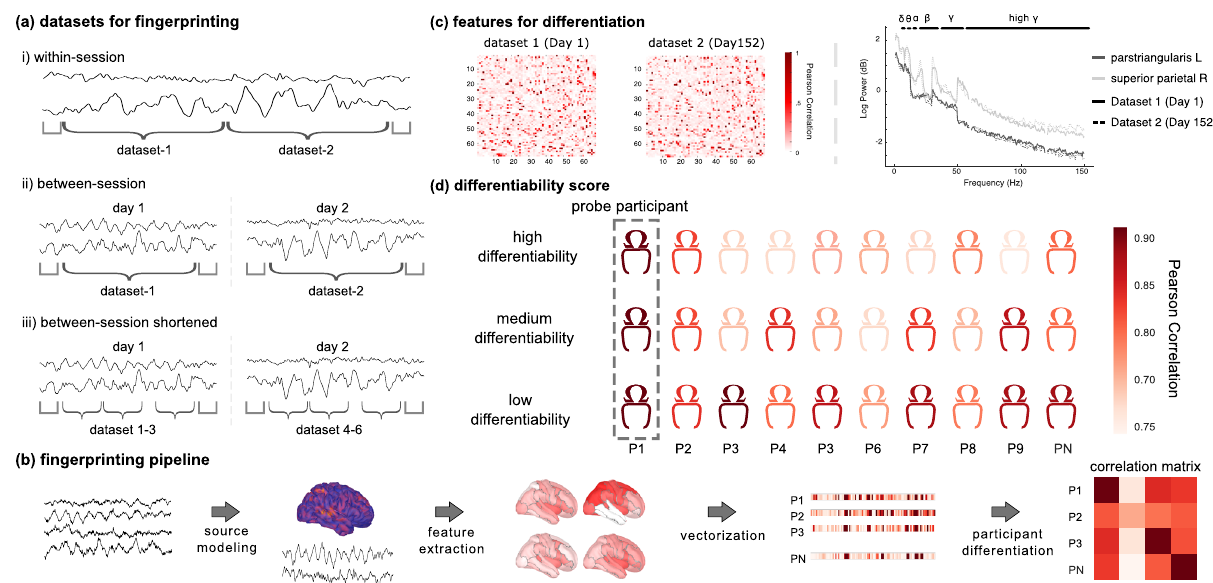
Fig. 1 Neural fi ngerprinting analysis pipeline and de fi nition of differentiability. a Schematic of exemplar MEG data divided into datasets used in each of the speci fi ed differentiation challenges. (i) Within-session challenge: the session data was split in half to generate segments of equal duration; (ii) Between-sessions challenge: differentiation was performed using data recorded on two separate days; (iii) Between-session shortened challenge: data recorded on two different days were split into three 30 s segments. b Schematic of the data analysis pipeline: source modeling was fi rst performed before extracting features from each region of the Desikan-Killiany atlas 37 . These features were vectorized and subsequently used to fi ngerprint individuals, yielding a participant correlation matrix. c Features for the between-session challenge from an exemplar subject. Left panel depicts amplitude envelope correlation (AEC) functional connectivity matrices across two datasets; both matrices feature the Pearson correlation coef fi cients between all 68 regions of the Desikan-Killiany atlas 37 . Right panel plots the power spectrum density estimates from two regions of the atlas, across two datasets. d Differentiability was derived for each participant as the z-score of their correlation to themselves, relative to the correlation between themselves and the rest of the cohort. A participant with a high correlation to themselves and low correlations to others was quali fi ed as highly differentiable. An individual highly correlated to both themselves and many others in the cohort was quali fi ed as less